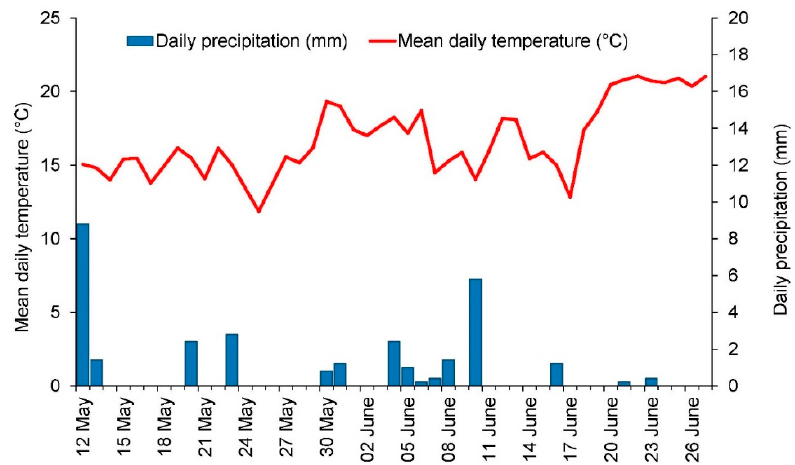
Figure 1. Daily mean temperature (°C) and daily precipitation (mm) data measured during the outdoor experiment.